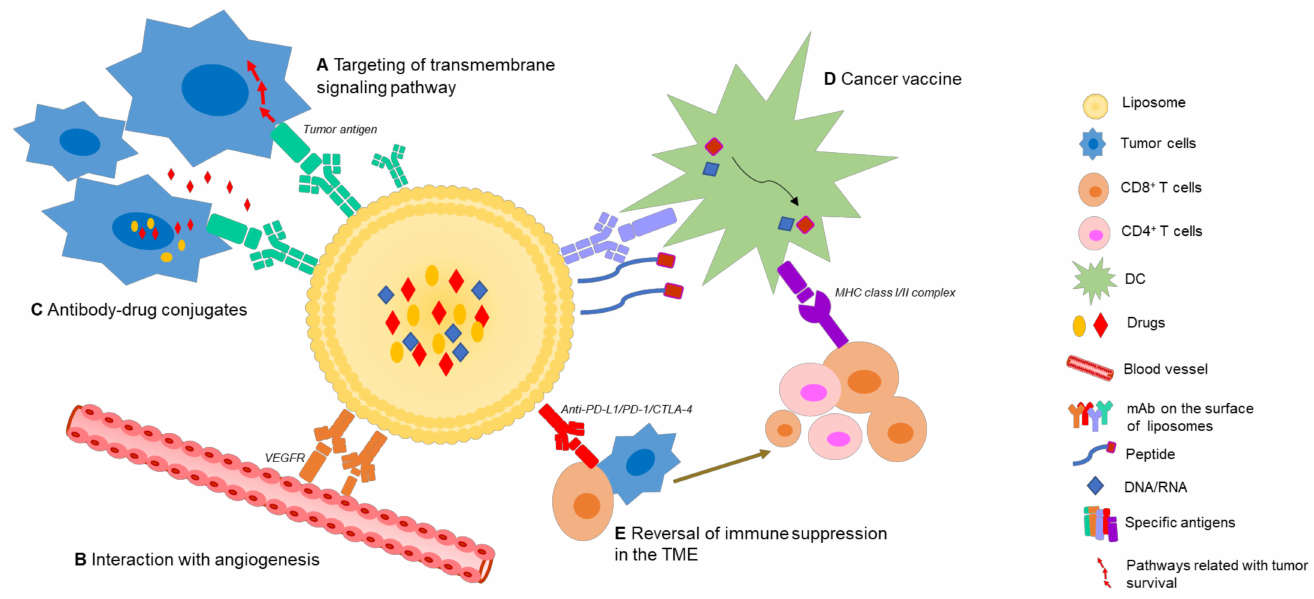
Figure 6. Therapeutic strategies of immunoliposomes and IILFs. (1) Antibody-conjugated liposomes: ( A ) directly inhibit tumor transmembrane signaling pathways related to survival by binding the specific antigens on tumor cells, ( B ) interact with the TME (for example, targeting angiogenesis) which delivers essential nutrients to the tumor, and ( C ) kill tumor cells by co-delivering drugs, including cytotoxic chemical drugs. (2) Immune-inducing liposomal formulations: ( D ) present antigens and/or adjuvants to APCs and stimulate an antitumor immune response and ( E ) block immune suppressive molecules on tumor cells (PD-L1) or immune cells (PD-1/CTLA-4). Abbreviations: TME (tumor microenvironment); PD (programmed death); mAb (monoclonal